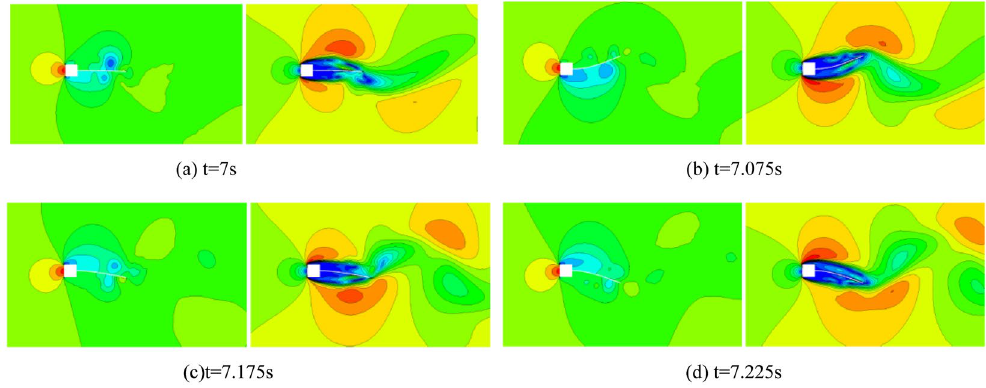
Figure 8. Pressure and velocity distributions of flow induced vibration of the flexible beam at Δ t 1 = 0.005 s.